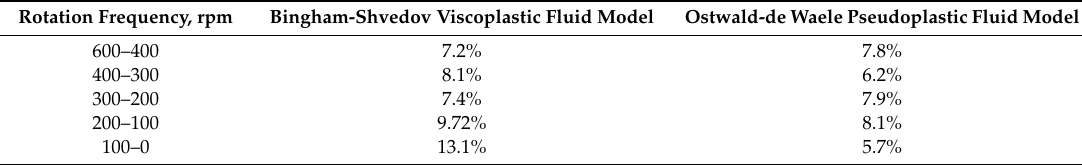
Table 8. Results deviation of measuring rheological characteristics from a mathematical